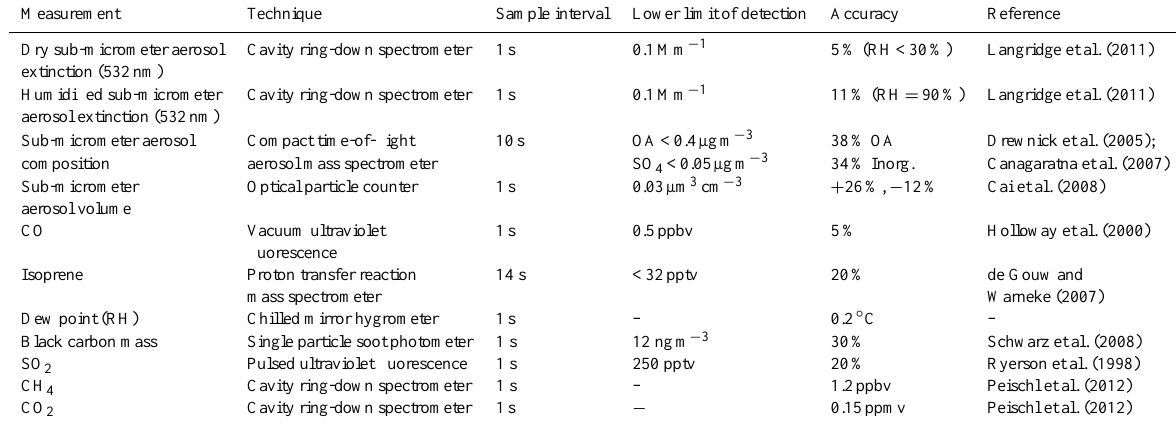
Table 1. Measurements aboard the NOAA WP-3D used in this analysis. The sample interval corresponds to the rate at which data are reported and is the integration time for the lower limit of detection.